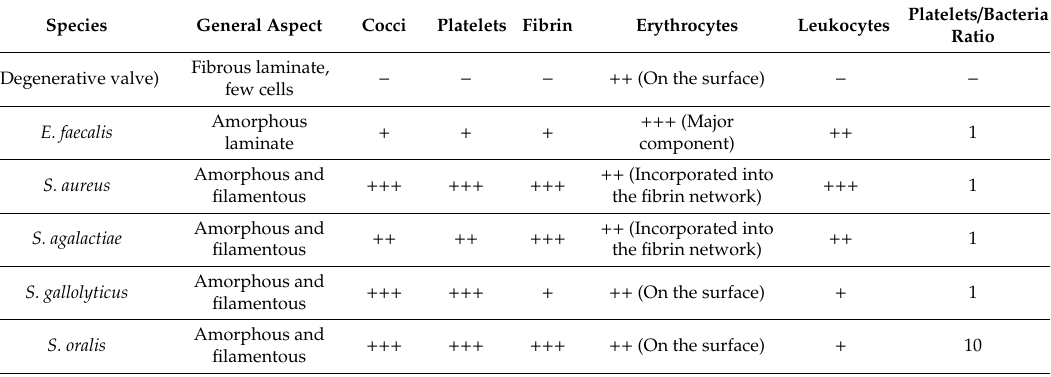
Table 2. Di ff erential cellular composition of the endocarditic vegetations according to the bacterial species